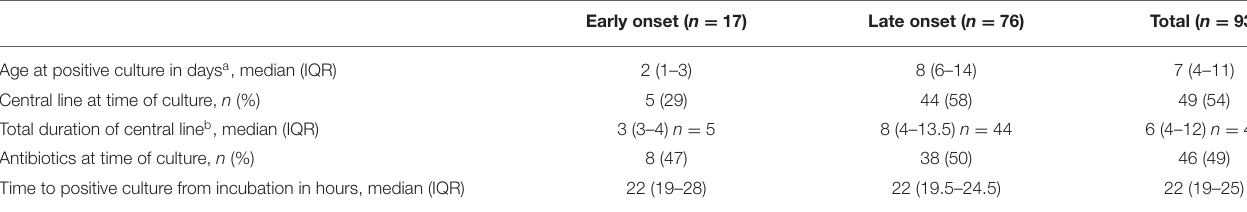
TABLE 2 | Characteristics of culture-positive infections in early onset and late onset